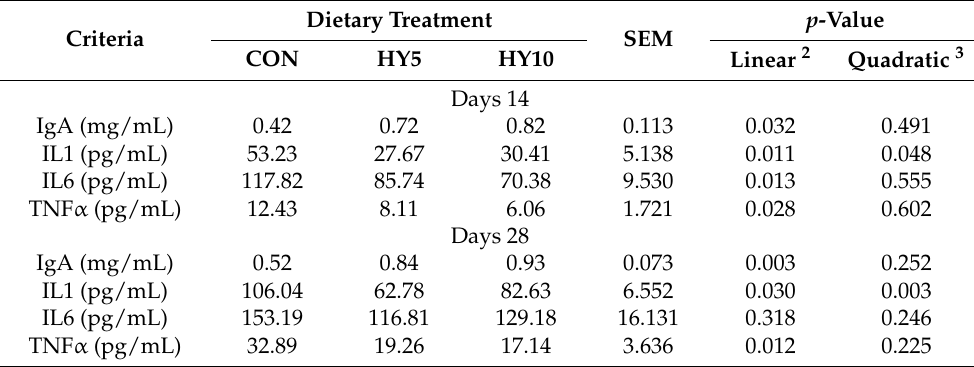
Table 6. Immunoglobulin and pro-inflammatory cytokines of early weaned piglets fed HY- supplemented diet 1 .